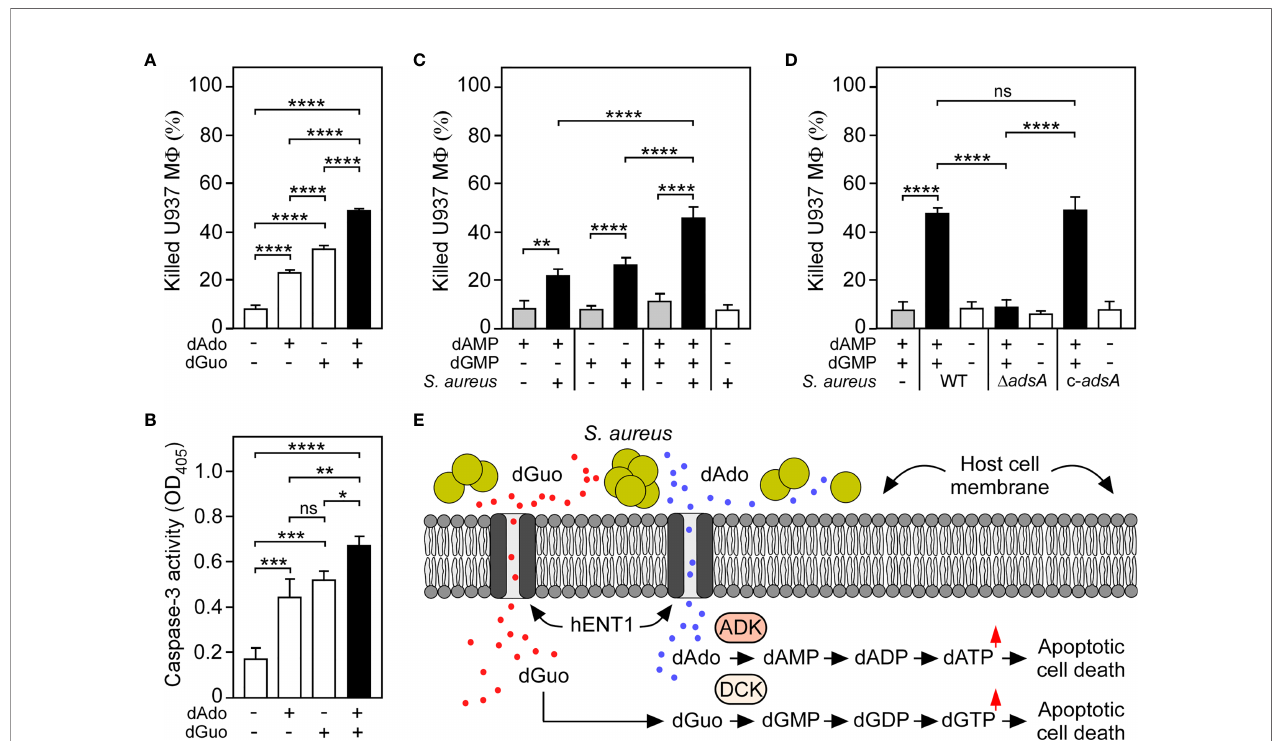
FIGURE 5 | S. aureus multiplexes death-effector deoxyribonucleosides to maximize macrophage cell death. (A) Survival rates of U937-derived macrophages (M Ф ) exposed to purine deoxyribonucleosides (dGuo and dAdo) as indicated with + and - symbols. (B) Lysates of purine deoxyribonucleoside-exposed (+) or untreated (-) WT U937-derived M F were analyzed for caspase-3 activity using a colorimetric assay. Cells were exposed to 160 µM of dGuo or dAdo alone, or received a combination of both (A, B) . (C) Survival of U937-derived M f after treatment with culture medium (RPMI 1640) that had been conditioned by incubation with wild- type S. aureus Newman in the presence (black bars) or absence (white bars) of dGMP and/or dAMP as indicated with + and - symbols. Controls included culture medium that had been conditioned by incubation with dGMP and/or dAMP only (gray bars). (D) Survival of U937-derived M F after treatment with RPMI 1640 that had been conditioned by incubation with either wild-type (WT) S. aureus Newman, its adsA mutant ( D adsA ), or the complemented adsA variant (c- adsA ) in the presence (black bars) or absence (white bars) of a dGMP/dAMP cocktail. Controls included culture medium that had been conditioned by incubation with a dGMP/ dAMP mixture only (gray bars). Cell survival rates or induction of apoptosis were analyzed 18 h (A, B) or 24 h (C, D) post-treatment. Data are the mean (± standard deviation [SD]) values from three independent determinations. Statistically signi fi cant differences were analyzed with one-way analysis of variance (ANOVA) and Tukey ’ s multiple-comparison test; ns, not signi fi cant ( P ≥ 0.05); * P < 0.05; ** P < 0.01; *** P < 0.001; **** P < 0.0001. (E) Scheme illustrating S. aureus -mediated killing of macrophages via synchronous targeting of the purine salvage pathway-apoptosis axis. hENT1 promotes uptake of S. aureus Nuc/AdsA-derived purine deoxyribonucleosides into phagocytes. dGuo (red spots) is converted via DCK to dGMP, while dAdo-based (blue spots) formation of dAMP is promoted by ADK and DCK. Generation of purine deoxyribonucleoside monophosphates triggers the accumulation of dGTP and dATP, ultimately culminating in the activation of caspase-3 and apoptotic cell